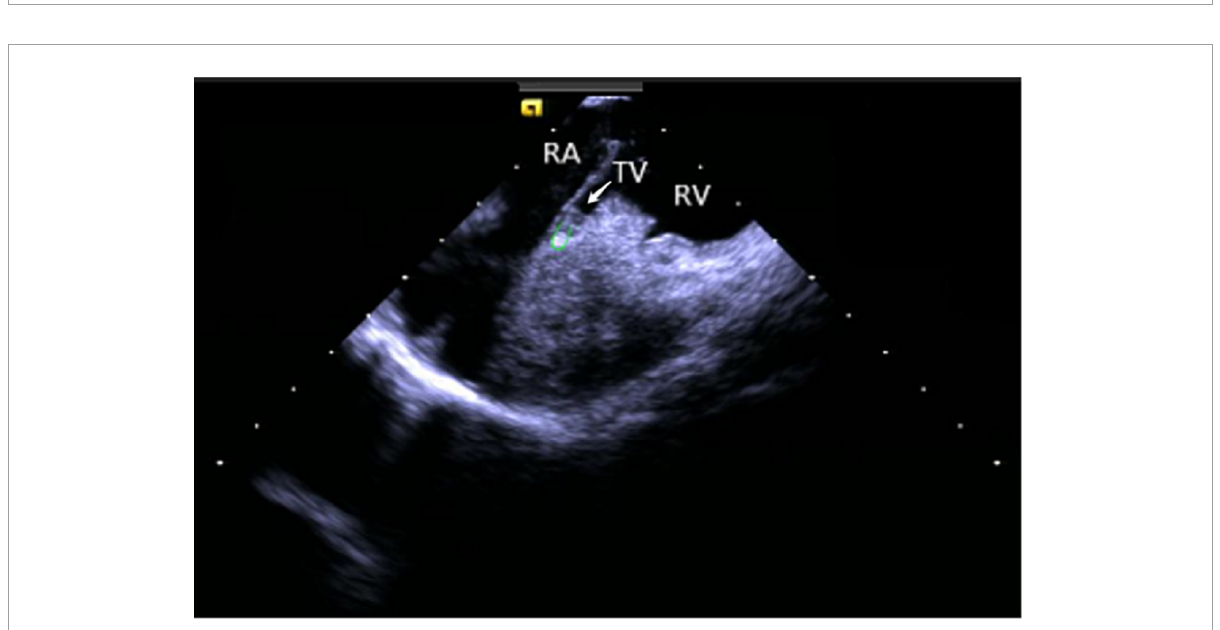
FIGURE4 Tricuspid annulus subvalvular reflex. RA, right atrium; TV, tricuspid valve; RV, right